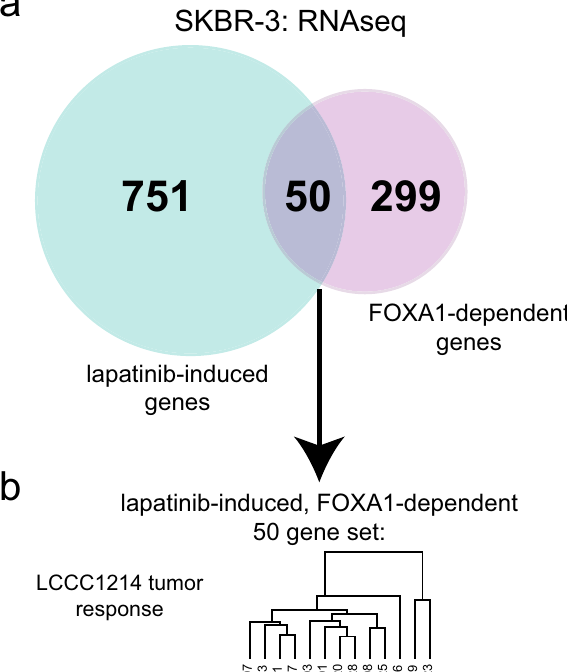
Fig. 6 A FOXA1-dependent adaptive response gene set discrimi- nates strongly responsive patient samples. a DESeq2 analysis of SKBR-3 cells treated with lapatinib vs. DMSO or with siRNA targeting FOXA1 vs. non-targeting siRNA was performed to identify genes upregulated or downregulated, respectively, with log 2 fold change of ≥ 1 or ≤ 1, respectively, and FDR cut-off of 5%. The number of genes in each list was compared and the overlap is shown in the Venn diagram to identify FOXA1-dependent genes responsive to HER2 targeting with lapatinib. b Log 2 fold changes in expression for matched patient samples from the gene set identi fi ed in ( a ) was used to perform unsupervised hierarchical